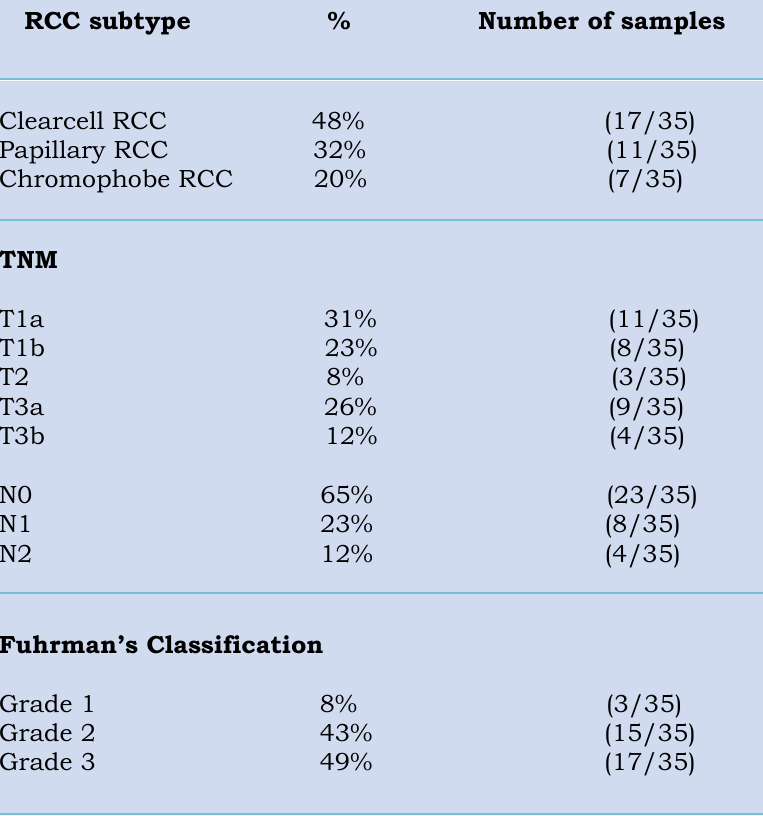
Table 2. Characteristics of patient